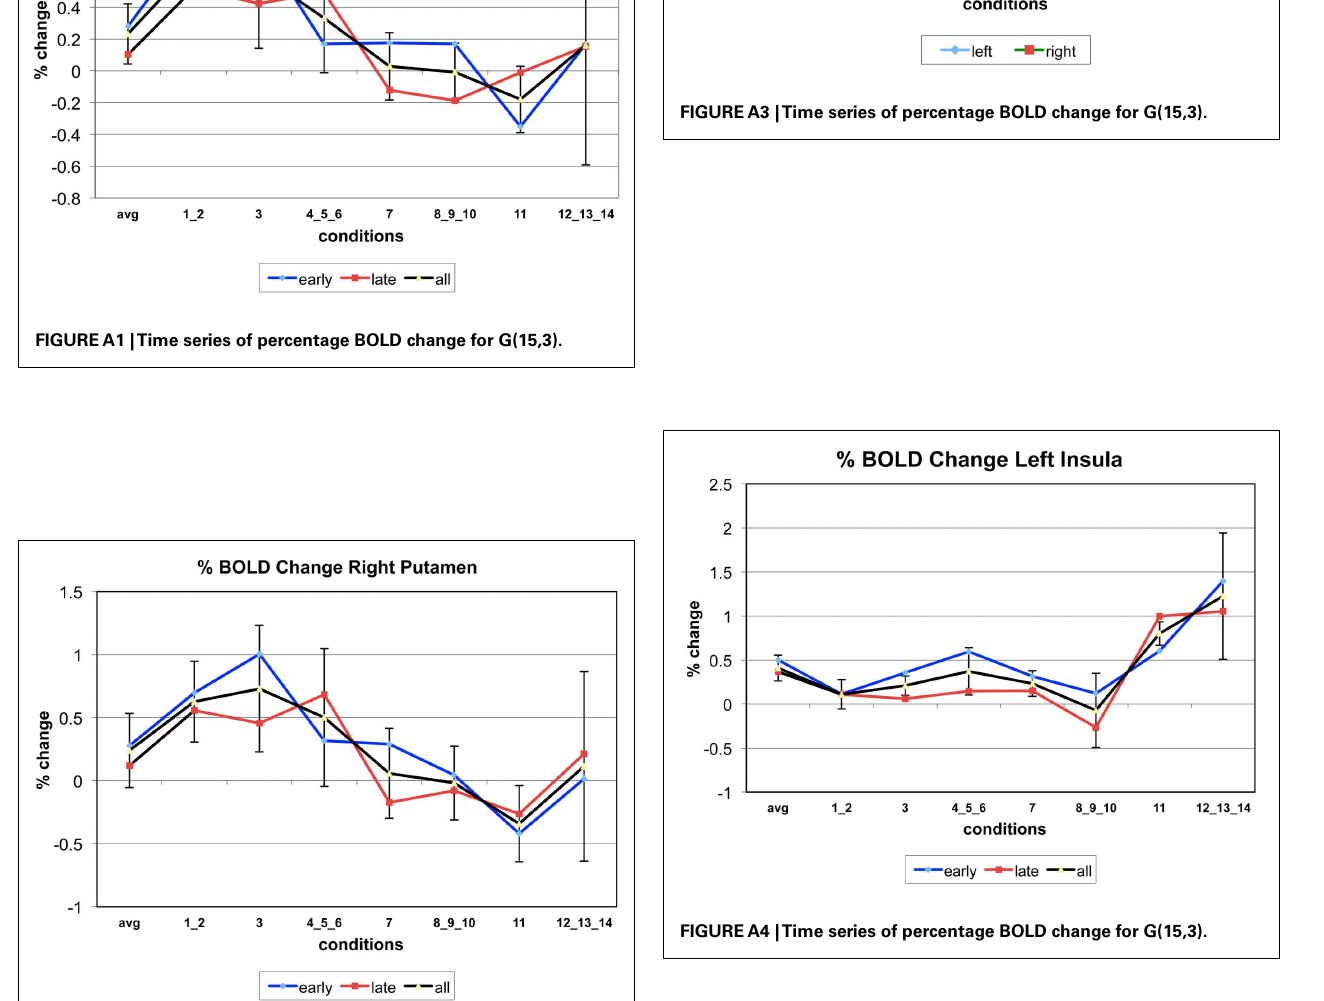
FIGUREA2 |Time series of percentage BOLD change for G(15,3).